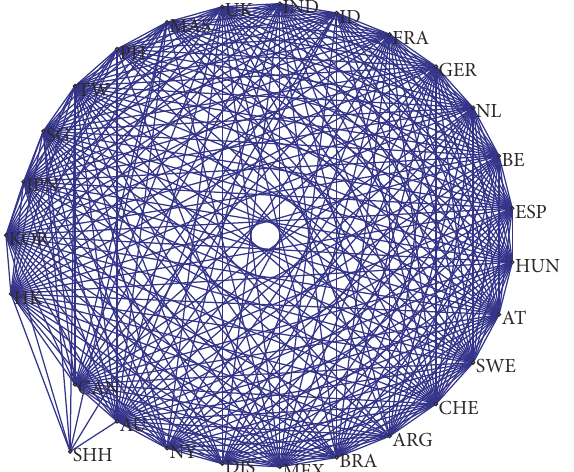
Figure 15: Topology graph of ISMN in